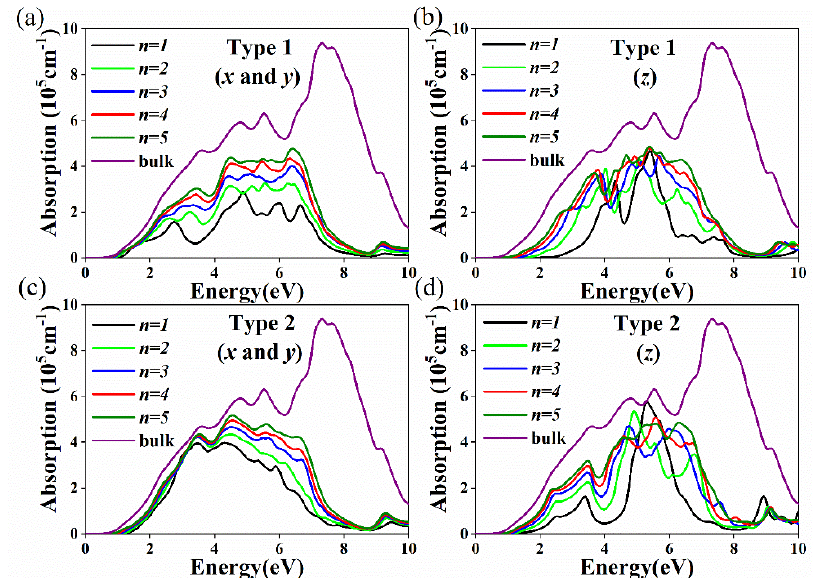
Figure 7. Calculated absorption coefficient for ( a ) Cs n +1 Sn n Br 3 n +1 ( n = 1–5) x and y directions; ( b ) Cs n +1 Sn n Br 3 n +1 ( n = 1–5) z directions; and ( c ) Cs n Sn n +1 Br 3 n +2 ( n = 1–5) x and y directions; ( d ) Cs n Sn n +1 Br 3 n +2 ( n = 1–5) z directions.